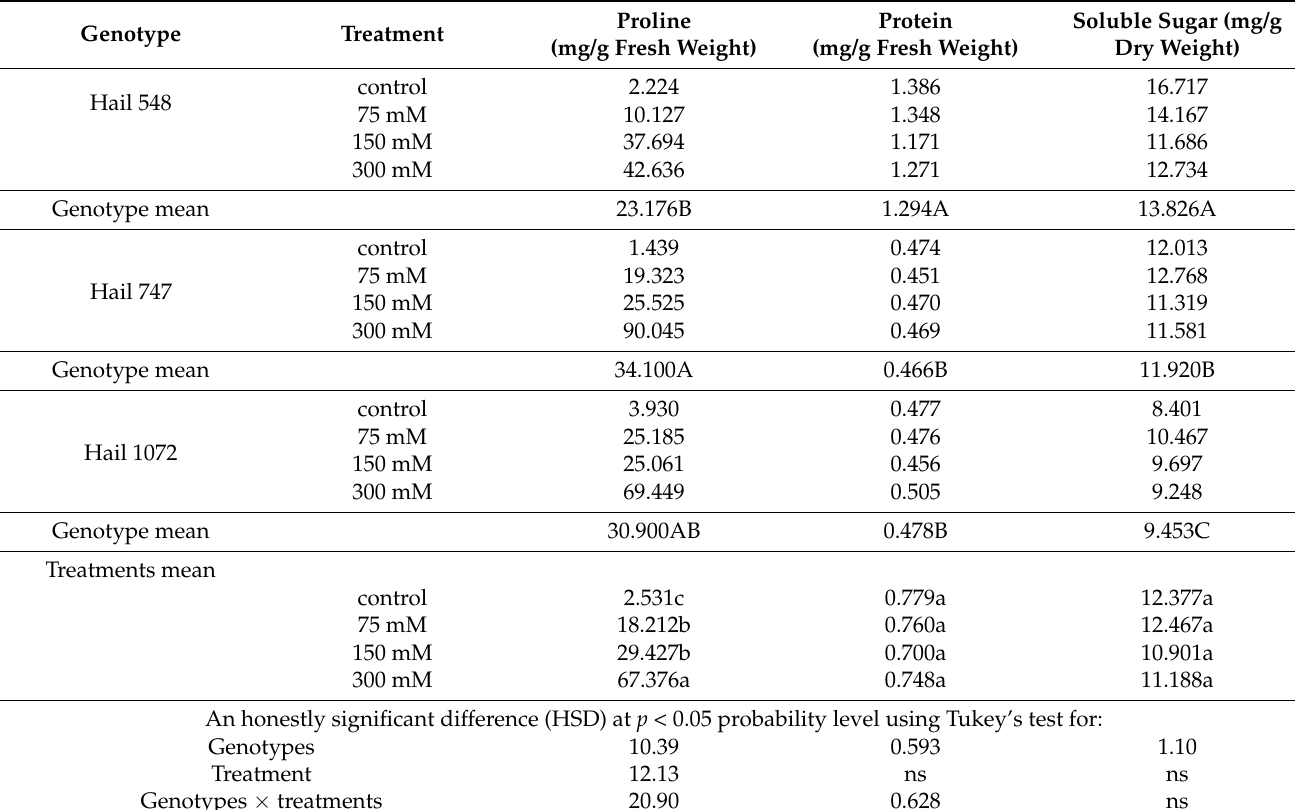
Table 3. Mean values of proline, protein, and soluble sugars for three Hail landraces under four NaCl stress treatments. Values are the mean of four replications. According to Tukey’s test, different letters within the same columns show significant differences ( p < 0.05). The higher cases are the differences among genotypes, and the lower cases are the differences among treatments’ mean. ns: means not